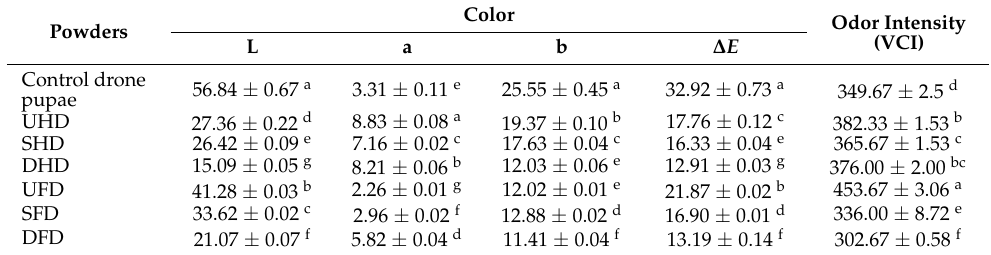
Table 5. The color and odor intensity of drone pupae powders processed using different treatment methods. Color Odor Intensity Powders (VCI)L a b ∆ E